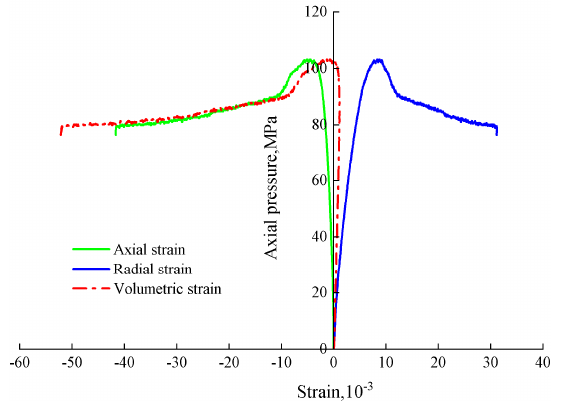
Figure 8. Typical core stress–strain curve.